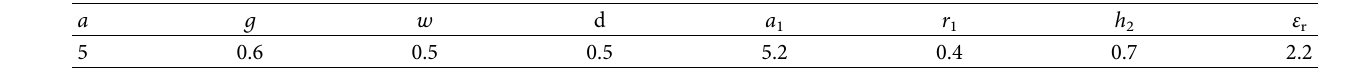
Figure 6: Metamaterial structure. Table 2: The dimensions of the proposed metamaterial structure in